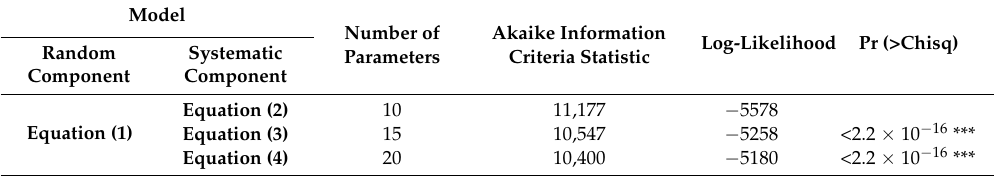
Table 4. Likelihood ratio test results comparing models of increasing complexity based on observed inundation depth. Model numbers are defined in the text above. Equation (2) refers to model based on a single TIM, (3) includes a debris term, (4) includes a debris-TIM interaction